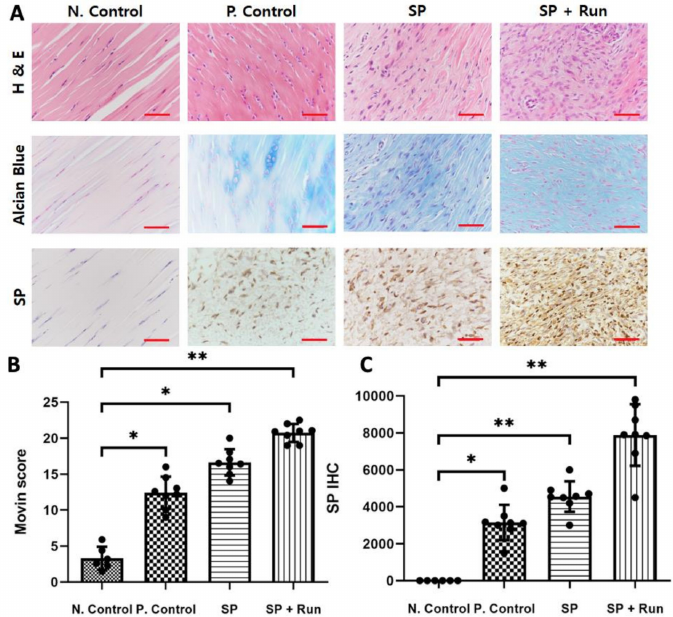
Figure 5. Histopathological changes and quantification after multiple substance P (SP) administration. Hematoxylin and eosin (H and E) and Alcian blue staining were used for the observation of SP and the appearance of collagen fibers and tenocytes ( A , B ). Movin scores used for selected samples to quantify the amount of tendon degeneration shown using H and E and Alcian blue staining ( C ). Data are represented as mean ± standard deviation. Kruskal-Wallis test with Tukey’s post-hoc test was used for statistical evaluation. n = 6 (N. control), n = 8 (P. control, SP, SP + Run). * p < 0.05 and ** p < 0.01. Scattered dots are used to show